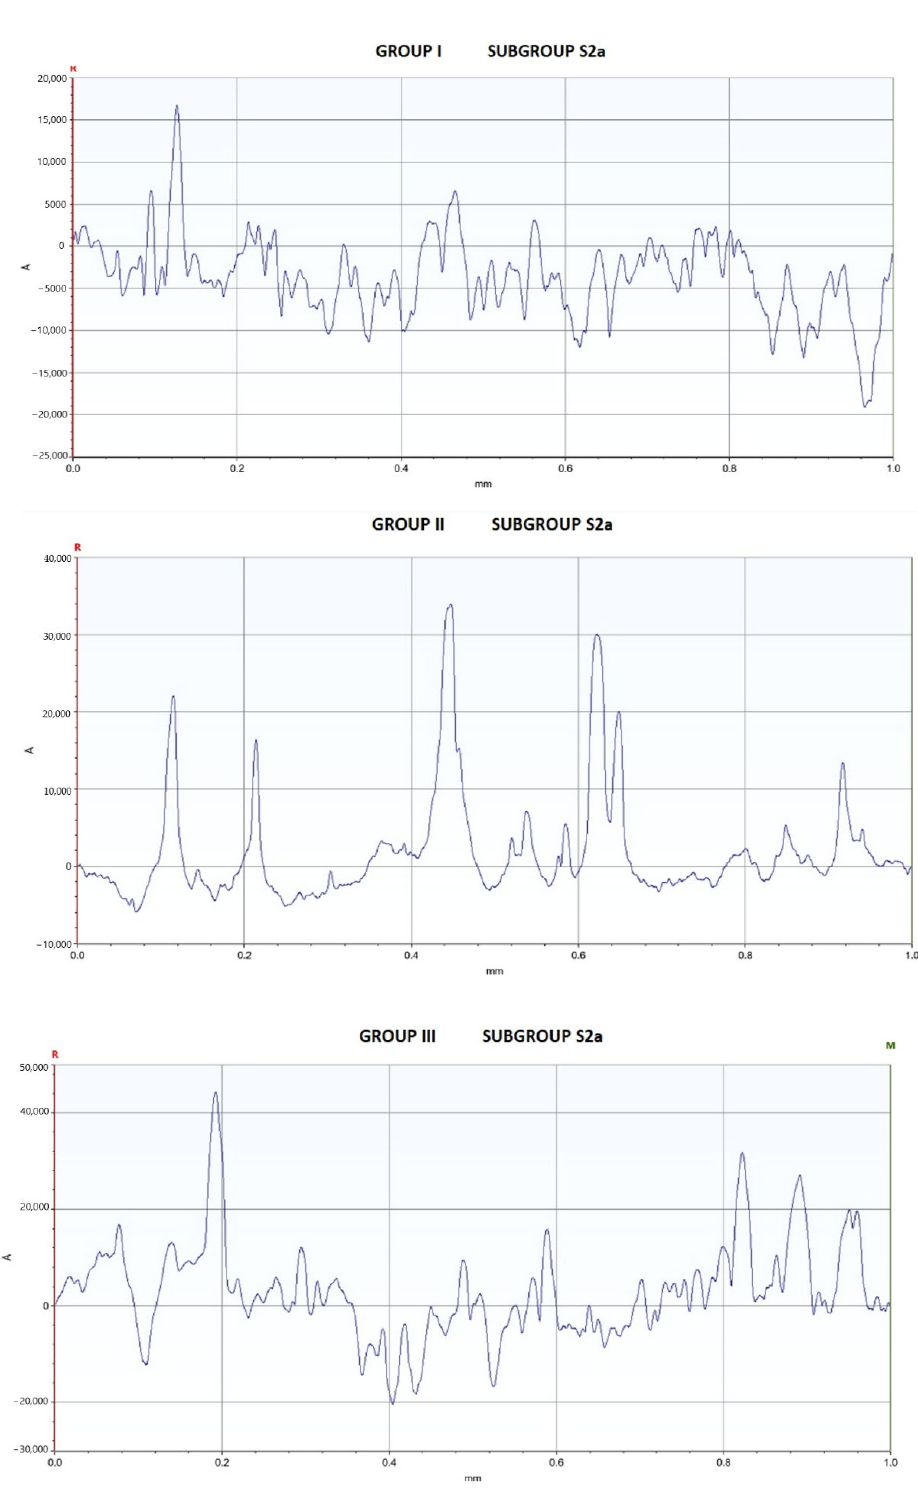
Figure 2. Profilometric measurements of samples in Group I, II and III, subgroup S2a .